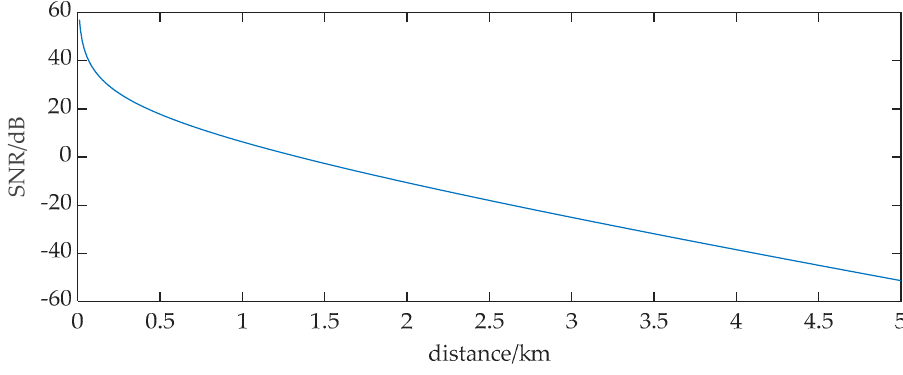
Figure 1. The variation of the received ULB signal SNR at different distances.